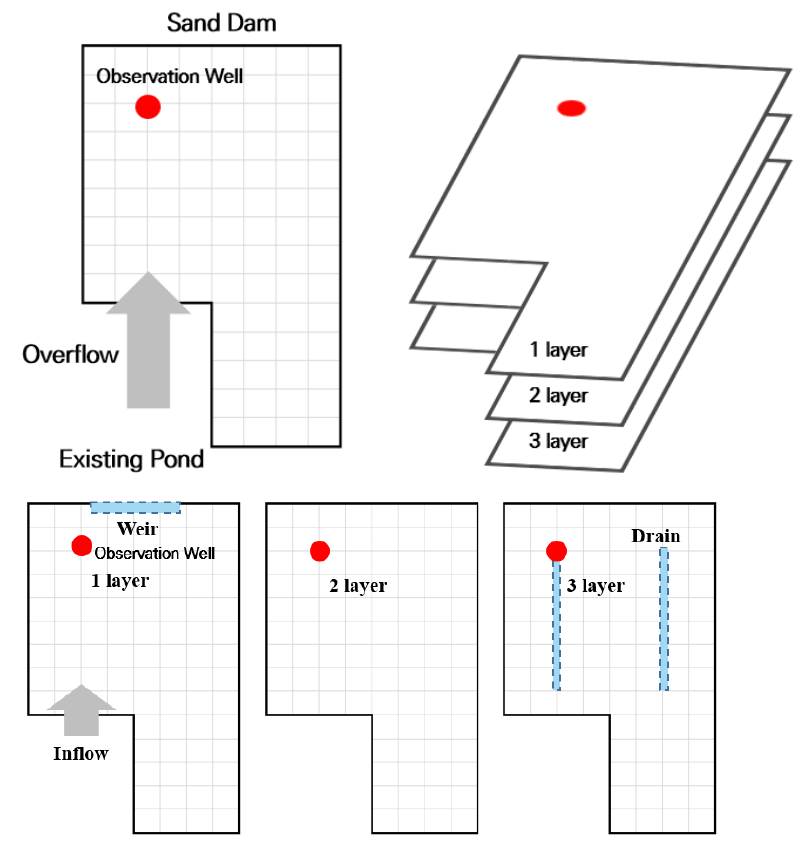
Figure 7. Discretization of modeling domain.